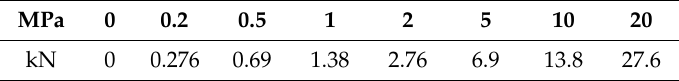
Table 1. The relevant tension level of the hydraulic